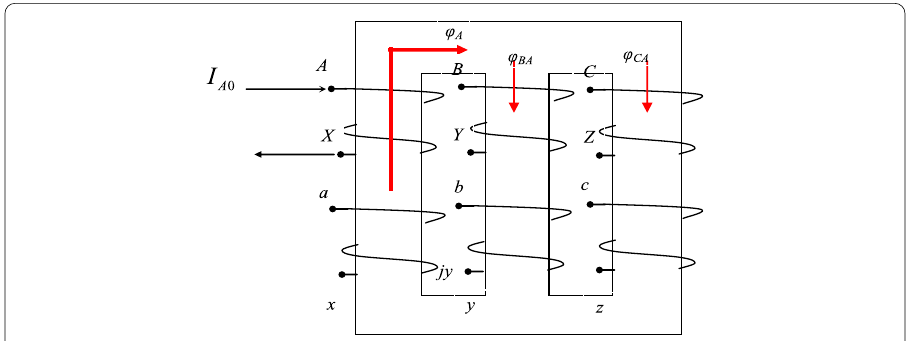
Fig. 12 Magnetic circuits of the three-phase three-limb core transformer; Magnetic circuits of the three-phase three-limb core transformer is showed when The current I A0 is bring to bear on A-phase winding in primary side